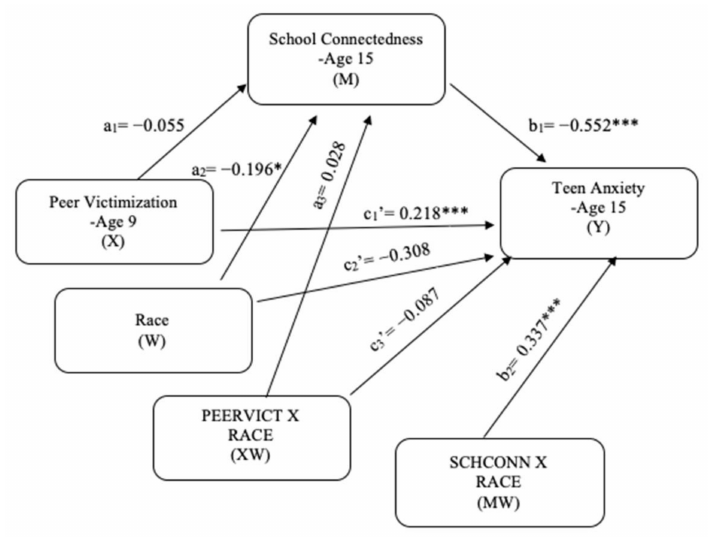
Figure 6. Moderated mediation model for teen anxiety. * p < 0.05; *** p <